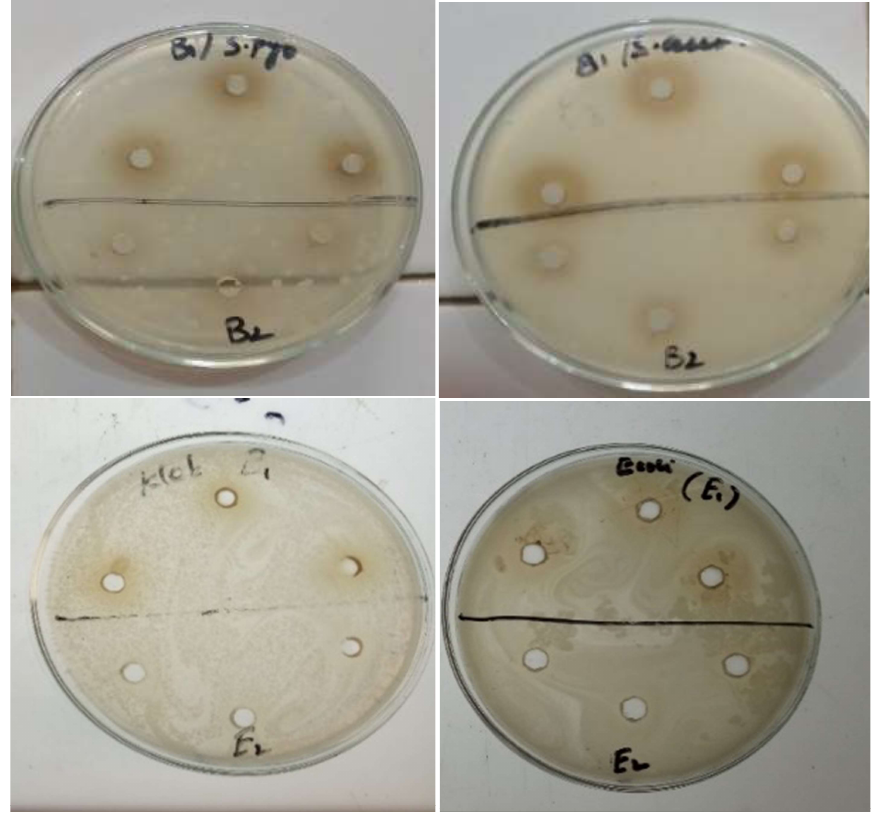
Figure 8. Experimental photographs of antibacterial activity of SnO 2 nanoparticles against Gram- positive and Gram-negative bacteria.